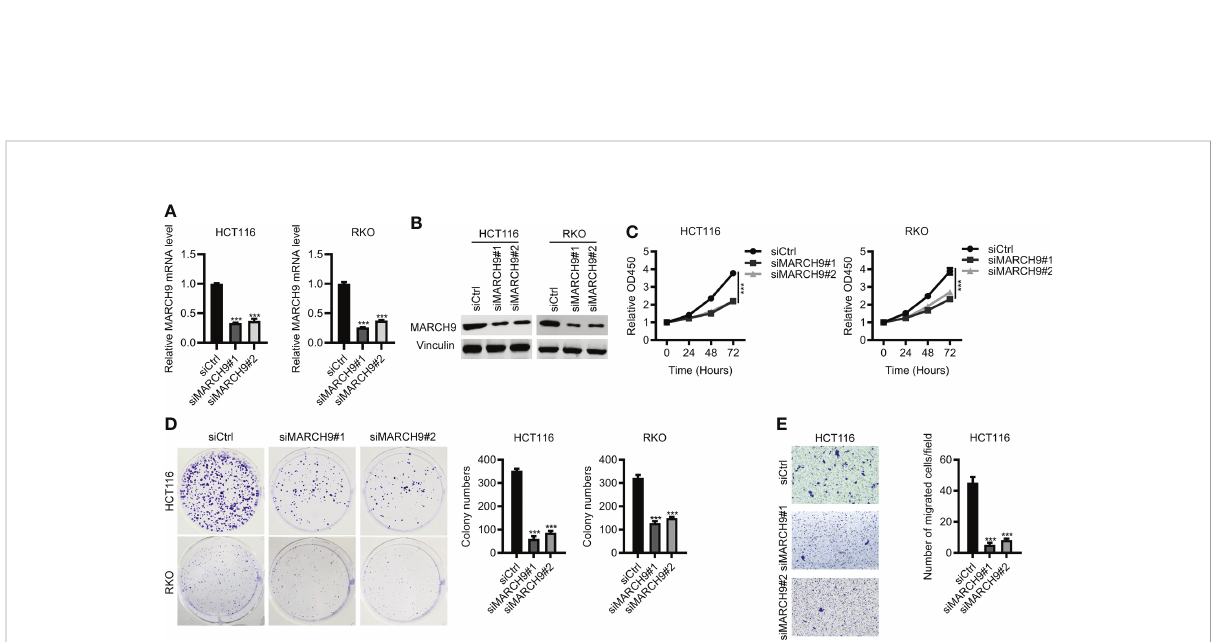
FIGURE 2 Knockdown of MARCH9 inhibited CRC cell proliferation and migration. (A, B) RT-qPCR and Western blot results of MARCH9 mRNA and protein levels in two CRC cell lines transfected with two MARCH9 siRNAs for 48 (h) (C) CCK-8 assay results of cell viability in two CRC cell lines transfected with two MARCH9 siRNAs at 24, 48, and 72h. (D) Cell colony formation results of two CRC cell lines transfected with two MARCH9 siRNAs at 14 days. (E) Transwell assay results of cell migration ability in two CRC cell lines transfected with two MARCH9 siRNAs at 48 (h) *** P <